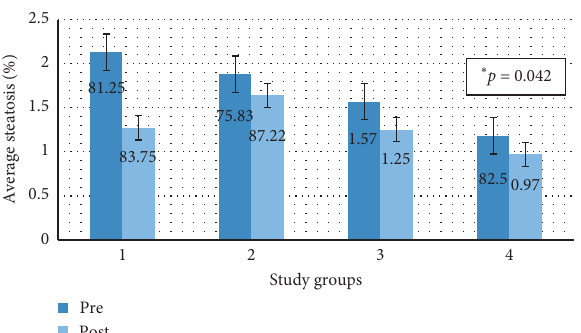
Figure 8: Average pre-post steatosis by study groups. Group 1: animals that maintained a steatotic diet and received concomitant treatment. Group 2: animals that maintained a steatotic diet and received no drug. Group 3: animals that did not continue with the steatotic diet but received melatonin treatment. Group 4: animals that did not continue with the steatotic diet and did not receive any drug.